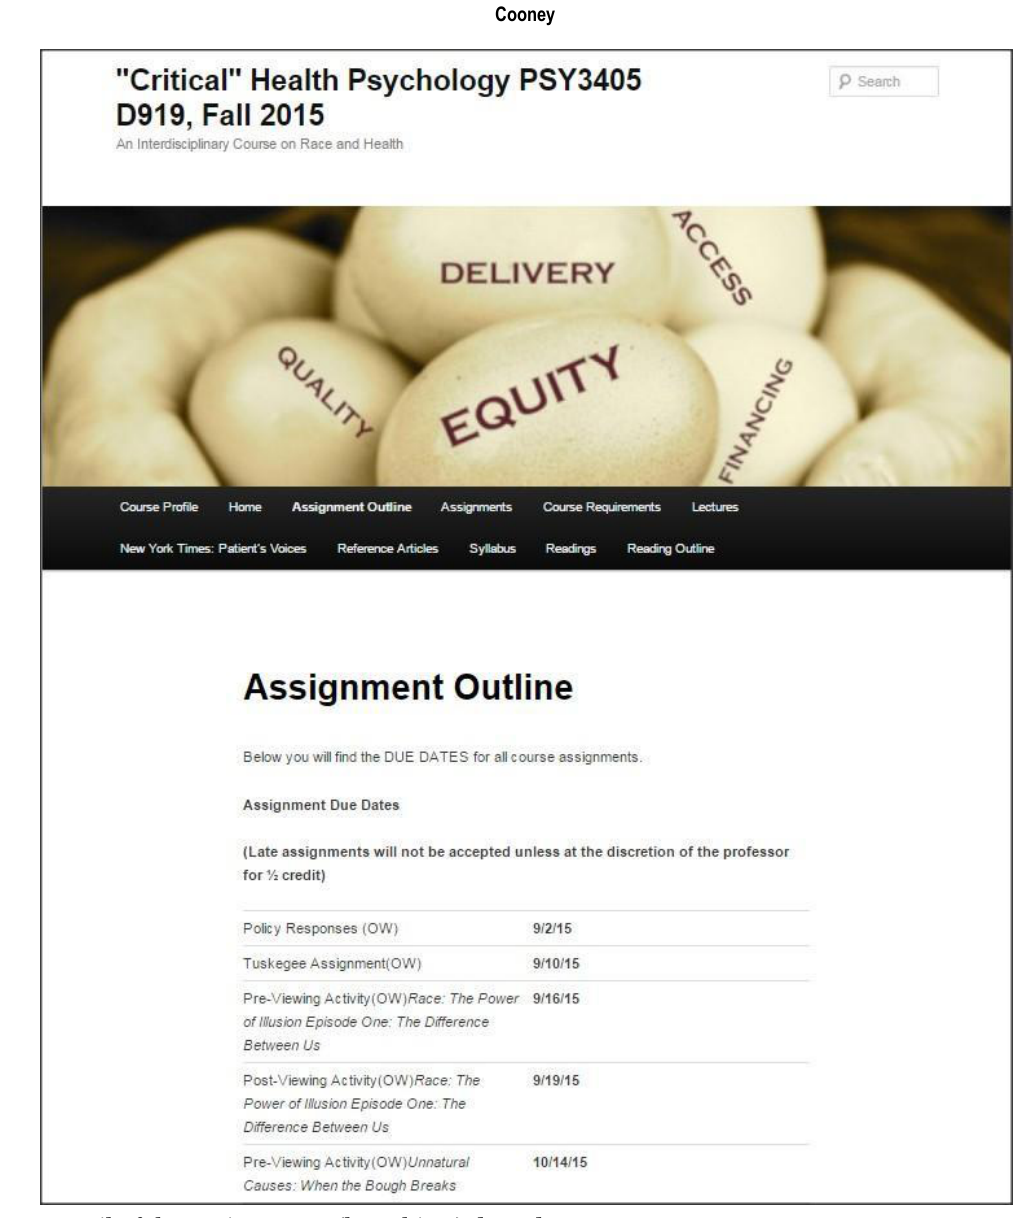
Figure 3. Detail of the Assignments (by subject) drop down